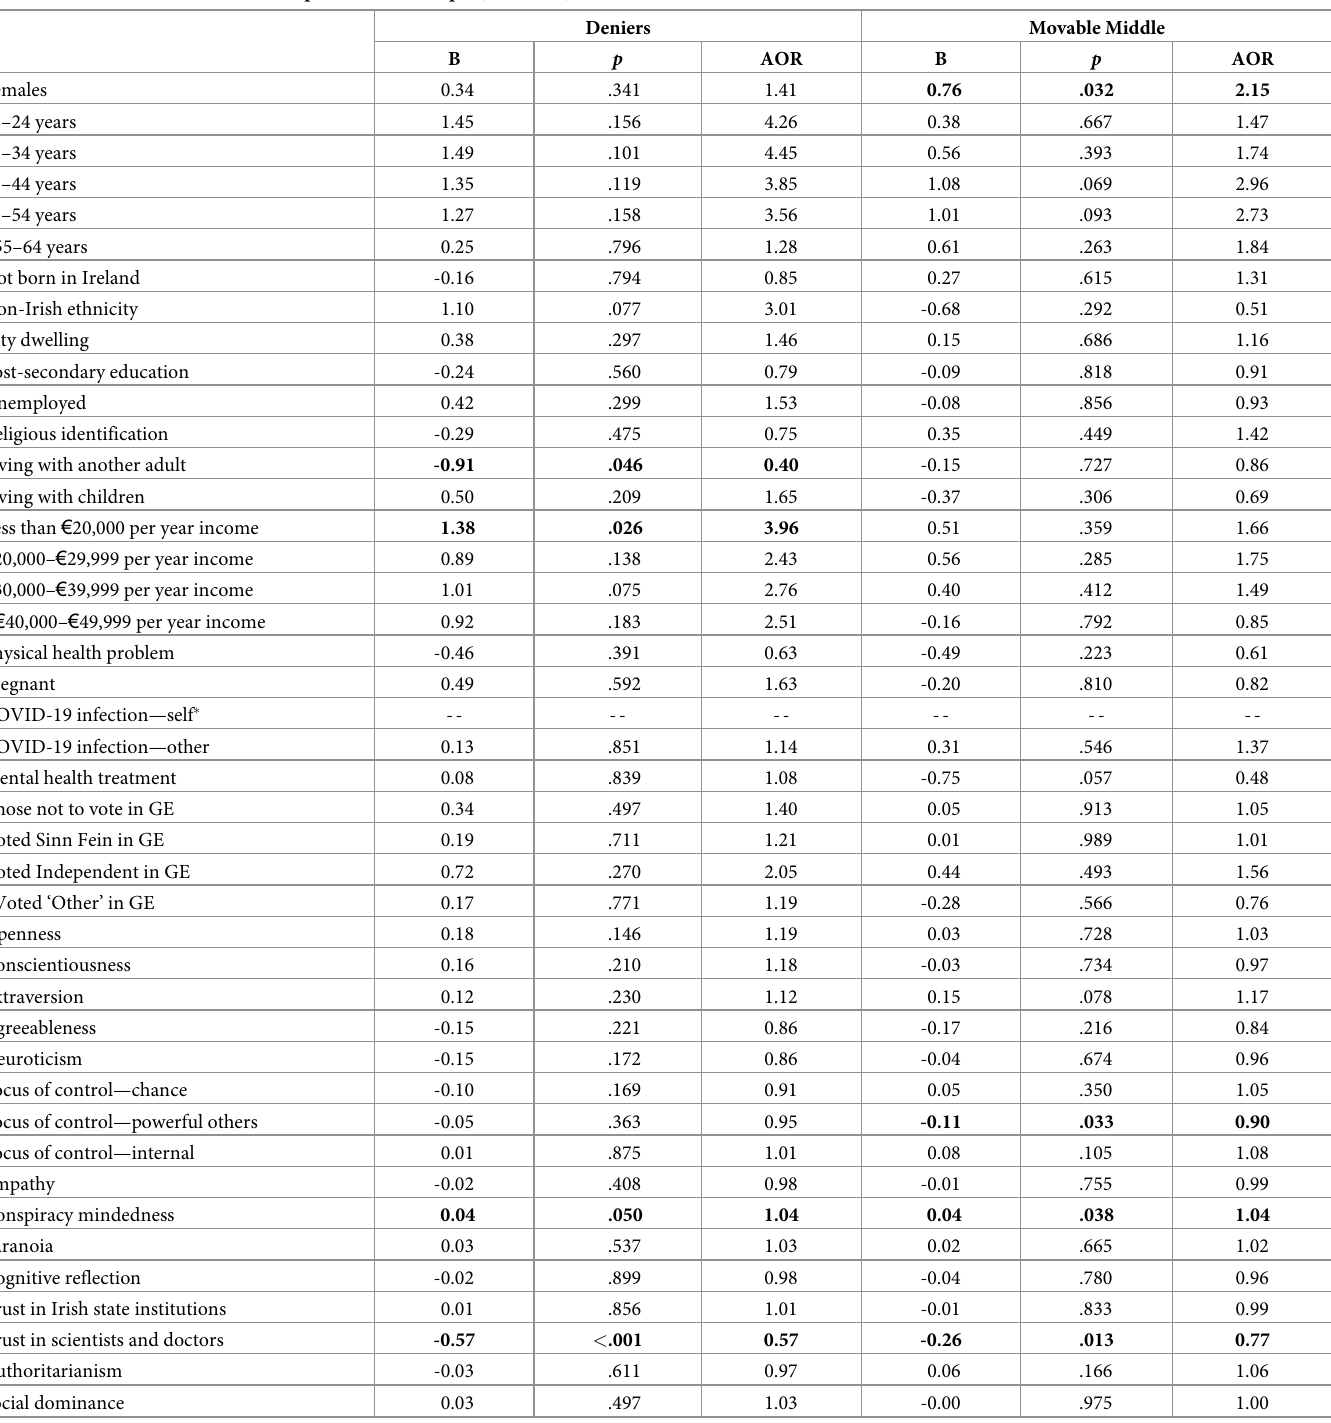
Table 4. Correlates of class membership in the Irish sample (N = 1,030).